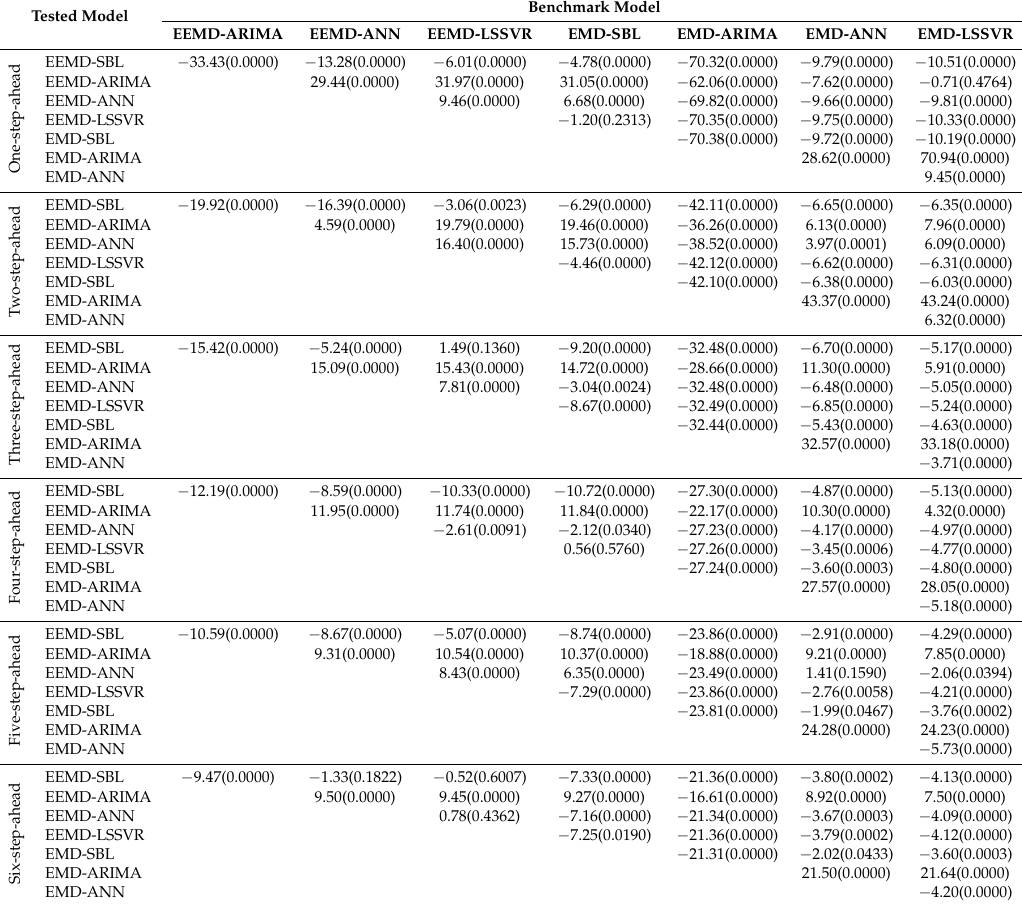
Table 10. DM test results for ensemble models on WTI crude oil